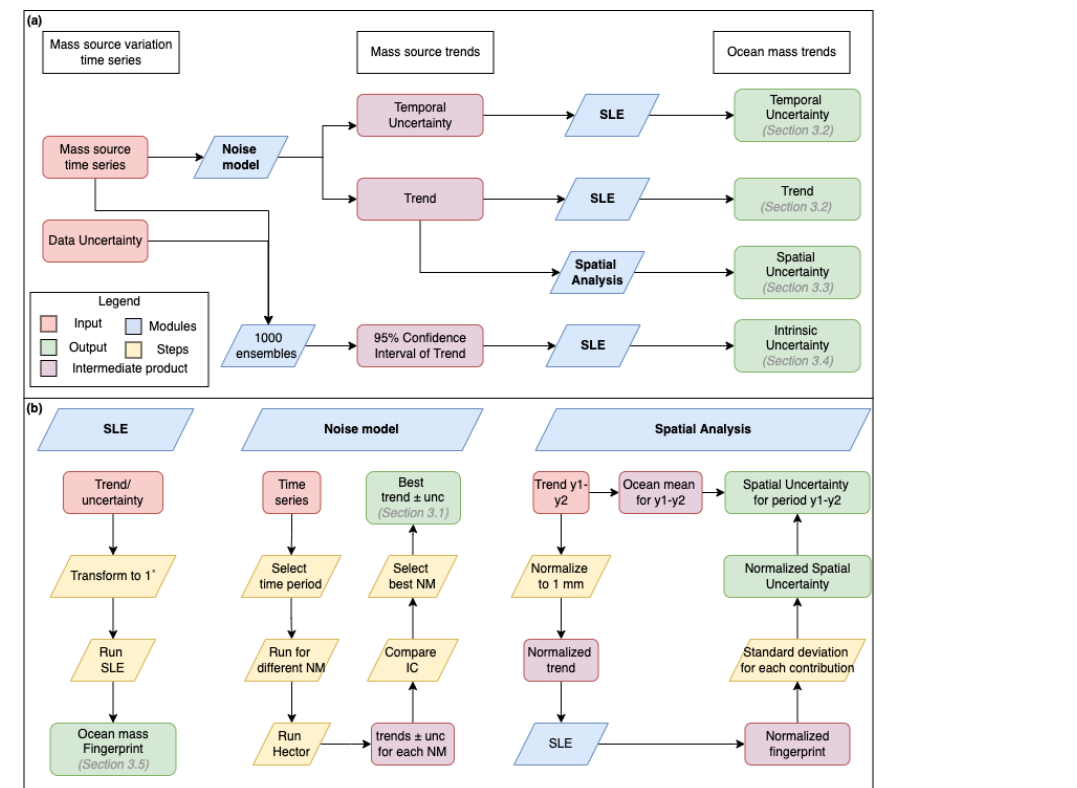
Figure 2. Overview of the framework used in this study (a) , with detailed modules (b) . Red boxes indicate the initial data (Table 1), purple the intermediate products and green the final products. The yellow boxes indicate steps of the methodology and the blue the main modules. We use the following acronyms and abbreviations: OLS: ordinary least squares; SLE: sea-level equation; IC: information criteria; unc: uncertainty; NM: noise model; Hector: software package by Bos et al.